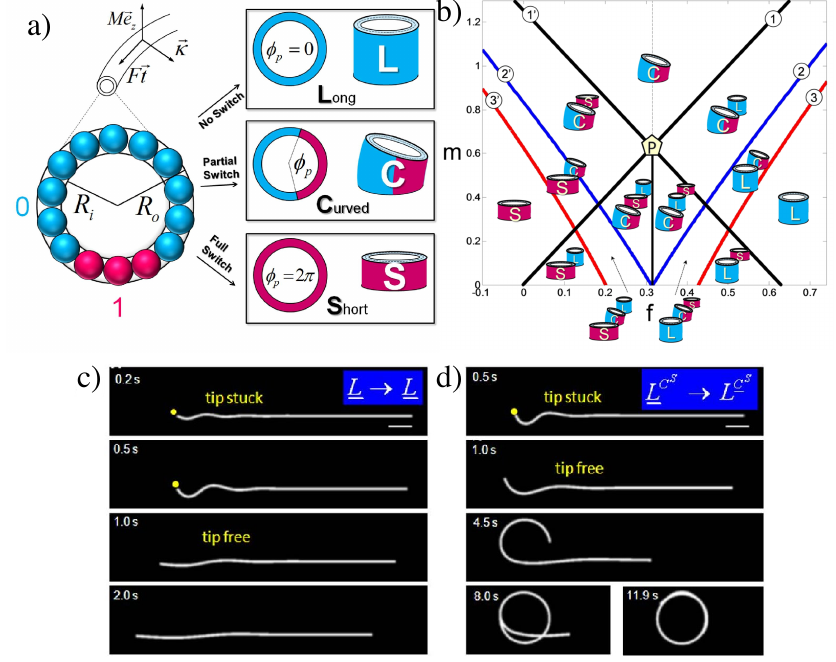
Figure 13. The polymorphic model of microtubules. ( a ) The switchability of tubulin dimers leads to a competition of three states of the microtubule’s cross-section: straight and long (L), curved (C) and straight and short (S). ( b ) “Phase diagram” of the polymorphic microtubule model as a function of generalized force f vs. torque m . The existing states in the respective regions are ordered by their polymorphic energies, the one at the bottom having minimum energy. ( c ) An intermittent buckling event, for a microtubule transported along a motor-covered surface, in case of f (cid:39) 0.7 (corresponding to small switching energies ∆ G (cid:39) 0). The behavior observed is the one of a regular WLC chain. ( d ) An intermittent buckling event in case of f (cid:39) 0.4 (corresponding ∆ G (cid:39) 5k B T ) . The microtubule curls